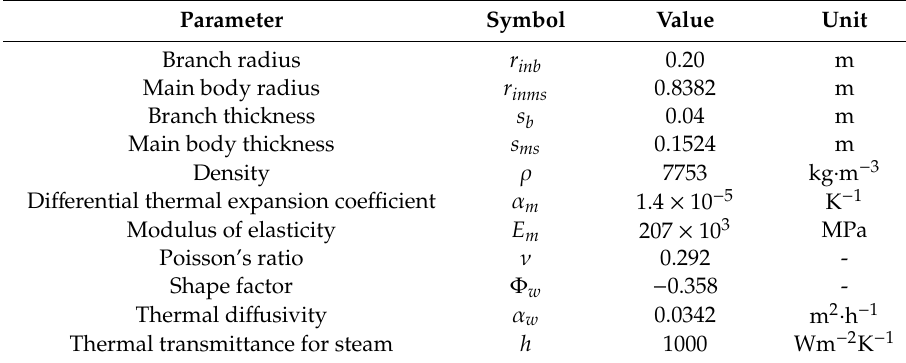
Table 2. High-pressure drum specification with MOC 1 being SA-515 grade